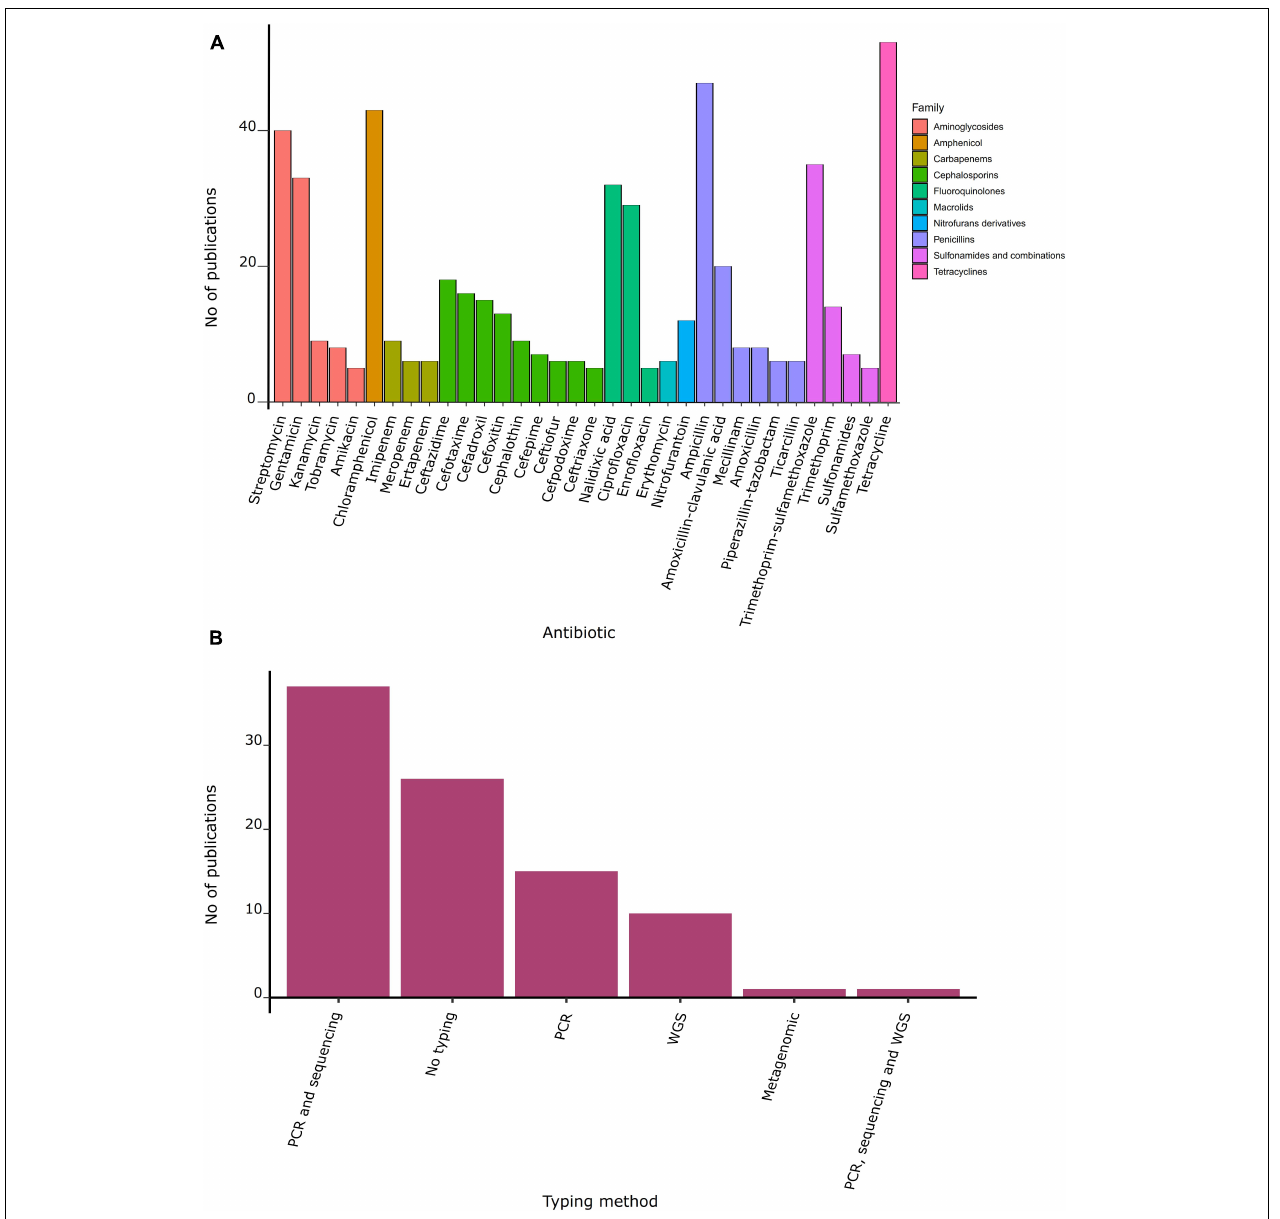
FIGURE 4 | Antibiotic resistance and molecular method used. (A) Number of publications by family of antibiotic. (B) Number of publications by typing